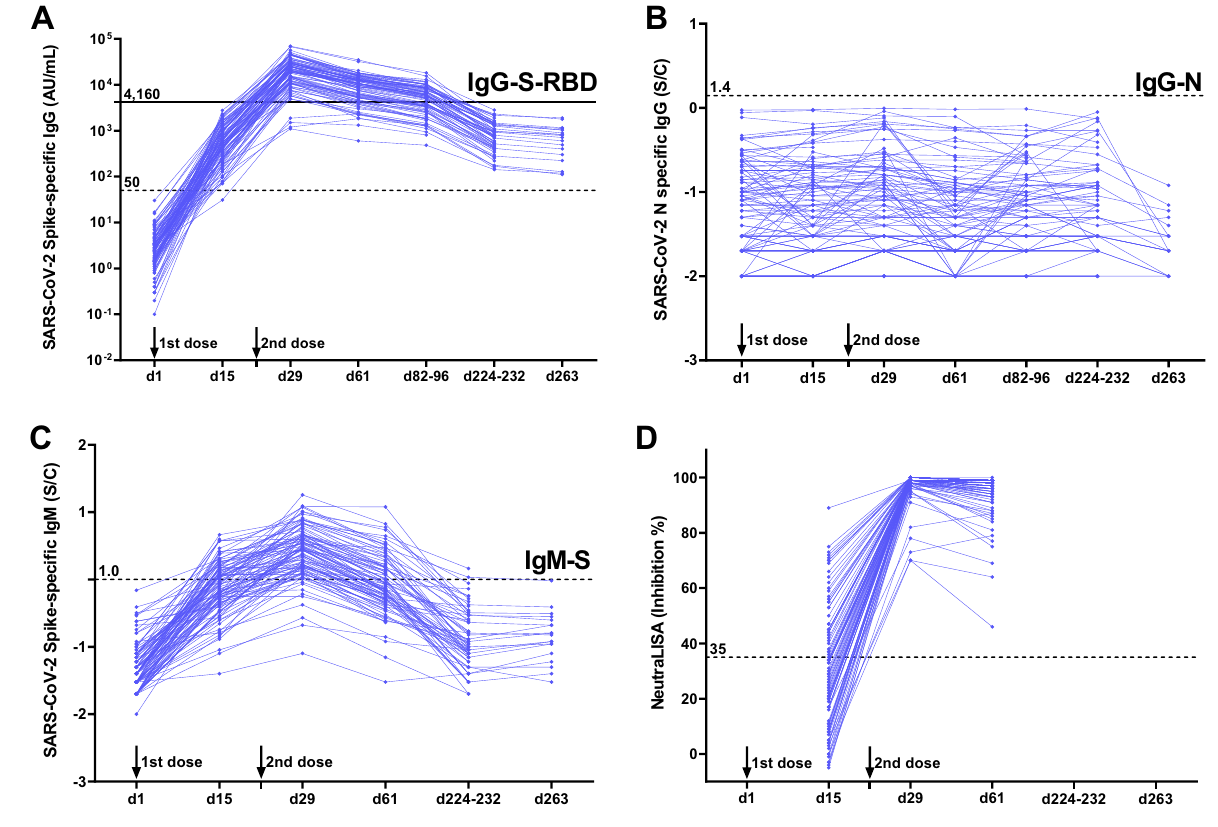
Figure 1. Humoral responses during and after BNT162b2 mRNA-based SARS-CoV-2 vaccination regimen. ( A – C ) Humoral responses on day 1 (immediately after the first dose) (n = 100), day 15 (n = 100), day 29 (7 days after the second dose) (n = 97), day 61 (n = 97), day 82–96 (n = 96), day 224–232 (n = 66), and day 263 (n = 19). IgG antibodies against SARS-CoV-2 spike protein ( A ), nucleocapsid ( B ), and IgM against spike protein ( C ) were measured using chemiluminescent microparticle immunoassay (CMIA). An ELISA-based semi-quantitative neutralization assay was also performed ( D ). Dashed lines indicate the cutoff for each assay. All data were represented as line graphs using GraphPad Prism 9.3.0. Black line indicates 4160 AU/mL as the cutoff, given that this threshold may correspond to a 95% probability of sufficient neutralizing